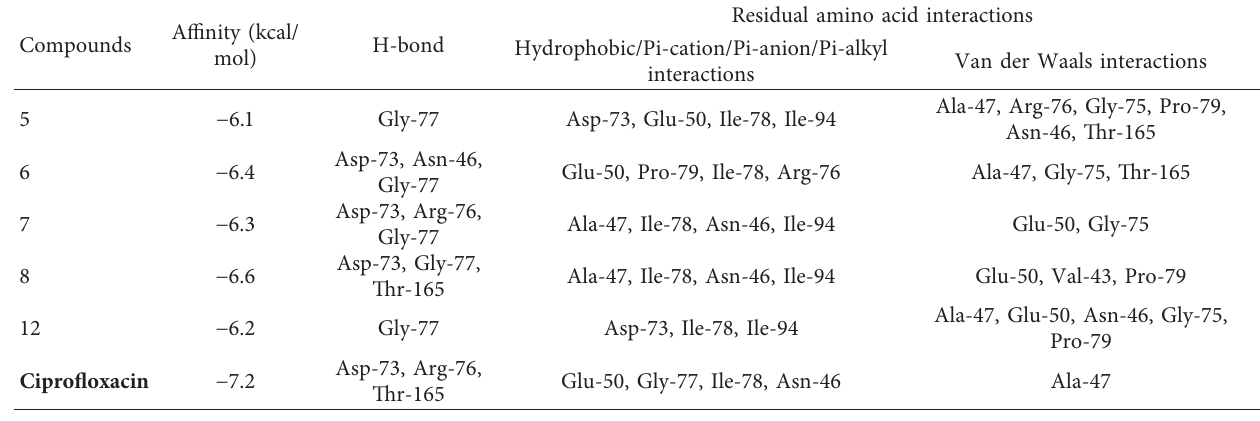
Table 3: Molecular docking value of synthetic compounds against E. coli DNA gyrase B.